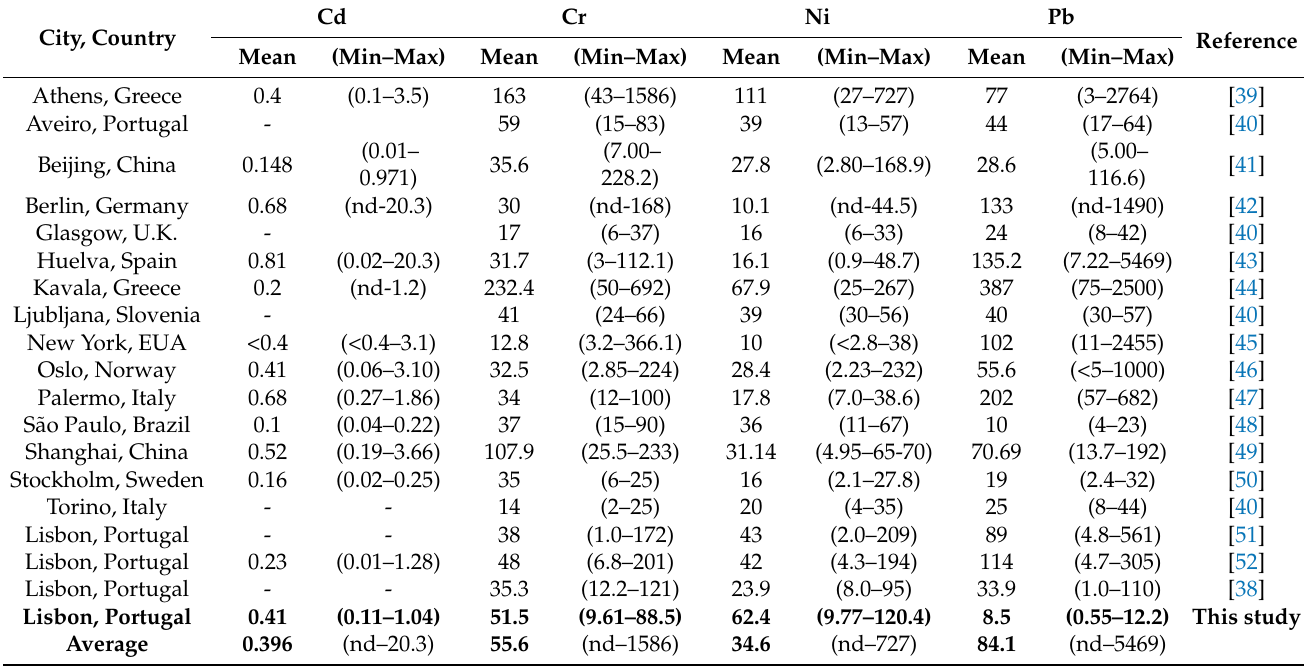
Table 3. Metal content (mg/kg) mean, minimum (min) and maximum (max) values from different places all around the